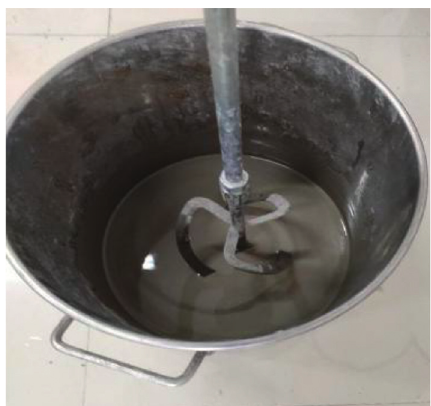
Figure 1: Mixed sealing material.